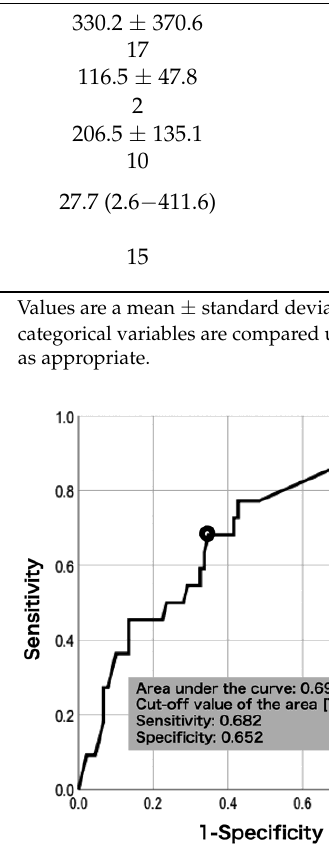
Table 2. Comparisons of non-fasting triglyceride (TG) profile during the follow-up period between the carotid stenosis progression and non-progressions groups.